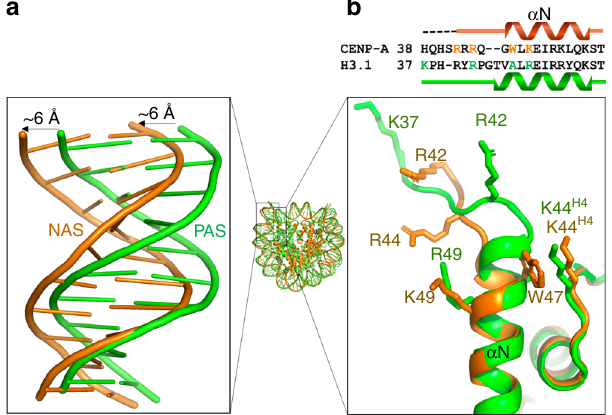
Fig. 4 The CENP-A nucleosome has a more open DNA conformation. a The cryo-EM structure of NCP CENP-A, NAS (orange) and the crystal structure of human NCP H3.1, PAS (green, PDB ID: 5AV6) were aligned using the core histones. Enlarged region shows the comparison of the DNA end regions. b Sequence alignment of the human CENP-A and H3.1 α N region with secondary structure element (top). Close-up view of the α N helix regions of CENP-A (orange) and H3.1 (green) (bottom). Side-chains of charged residues in CENP-A or H3.1 that interact with nucleosome DNA ends are shown as sticks. Side-chain of CENP-A Trp47 corresponding to Ala47